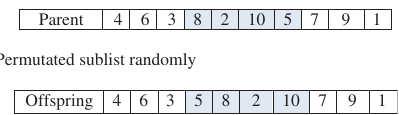
Figure 5: Show Scramble Sublist Mutation.